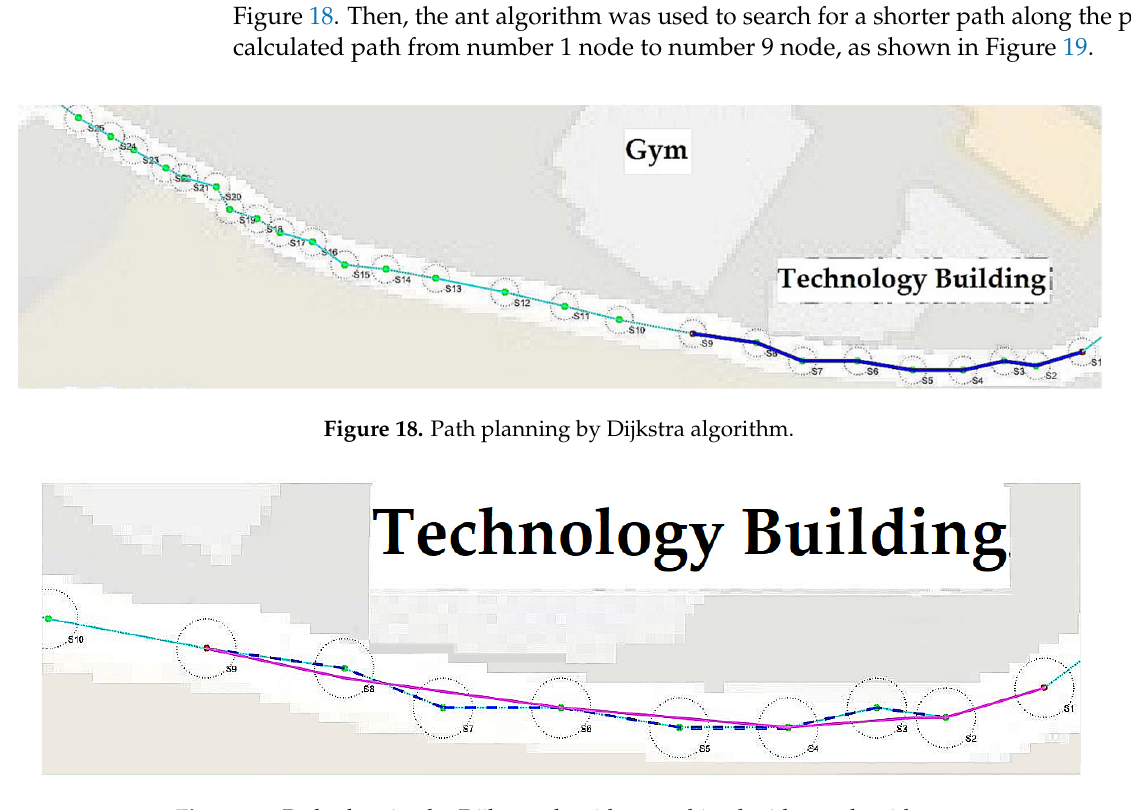
Figure 19. Path planning by Dijkstra algorithm combined with ant algorithm.